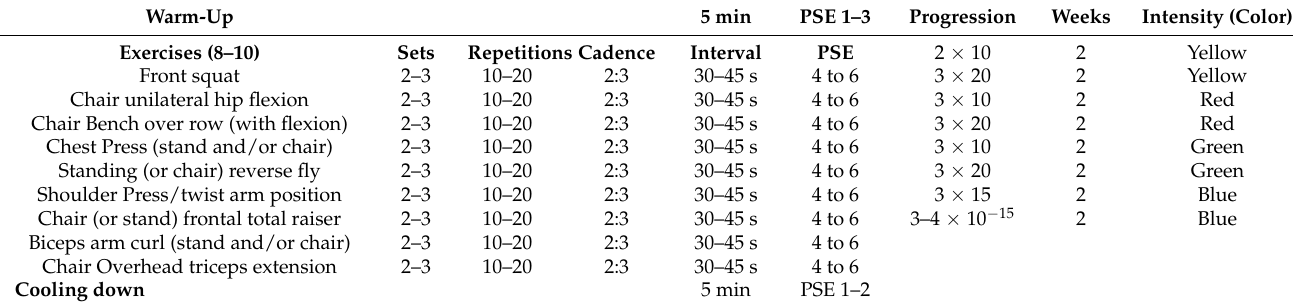
Table 1. Example of elastic-band exercise sessions applied in phase